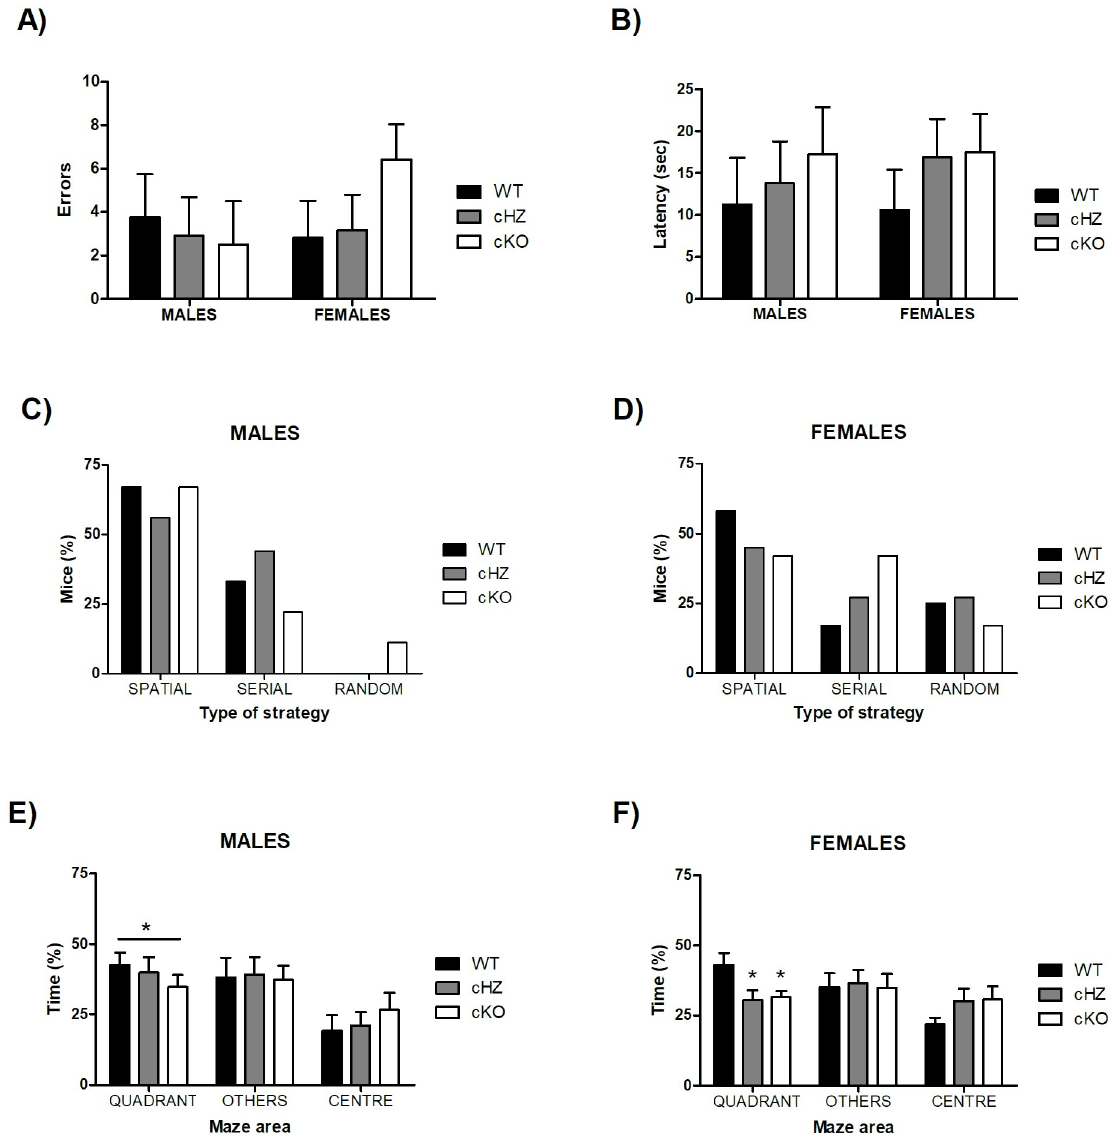
Fig 6. Spatial memory: BM probe. The bar plots (Mean and SEM) represent the number of errors ( A ), the latency to find the target ( B ) and the percentage of mice using the spatial, serial, and random strategies (C and D) , and the percentage of time spent in different positions of the maze (quadrant, others, centre) (E and F) , for Males (n = 9) and Females (n = 12). Three groups were compared: WT ( Grik4 Cre+/+ , SV2A lox/lox ), cHZ ( Grik4 Cre+/- , SV2A lox/+ ), and cKO ( Grik4 Cre+/- , SV2A lox/lox ). ( � ) indicates that the corresponding marginal means of both cKO and cHZ groups are significantly different to the WT group (main effect of Genotype ), as yielded by a Tukey HSD test taken at p <